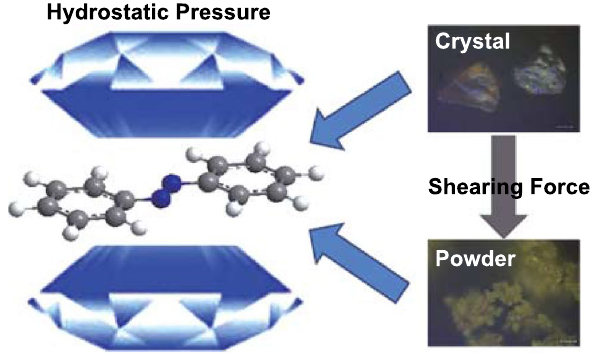
Fig. 20 Structural changes in the trans -azobenzene single crystal and powder upon compression realized in the DAC